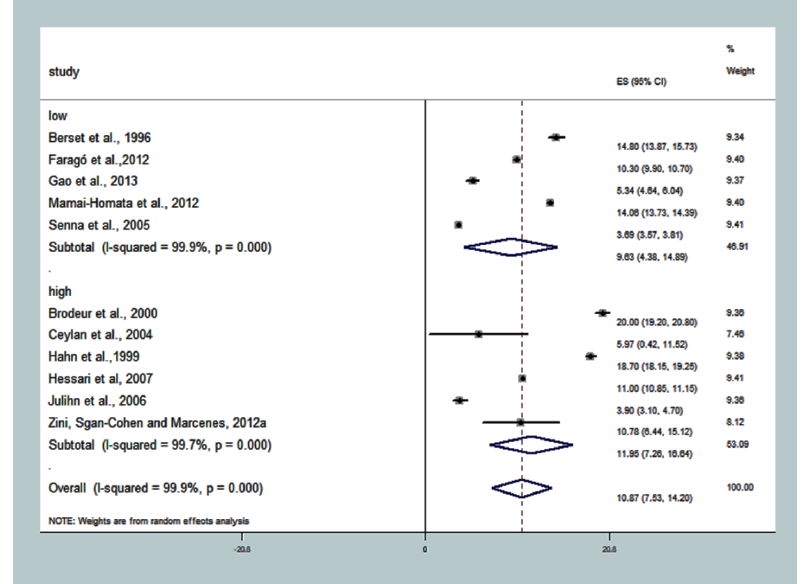
Figure 4. Association between subgroup ‘low level of schooling’ and caries experience (DMFT). The pooled effect estimates from the random-effects meta-analysis are shown. Heterogeneity was assessed using the χ 2 test and I 2 statistics. The forest plots are comparing caries in adults with ≥ 33.60% of the population with a low level of schooling-low compared with <33.60% of the population with a low